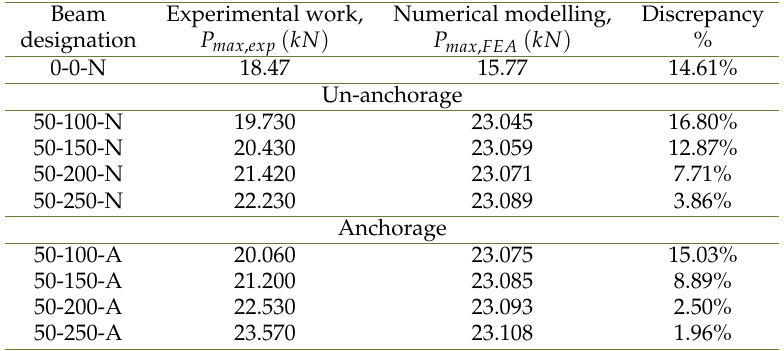
Fig. 15. Load versus mid-span deflection curves. Table 4. Comparison of the maximum load of experiment and simulation work in beam-CFRP plate models